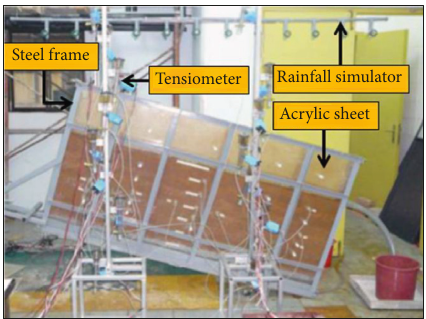
Figure 1: Laboratory slope model [5].